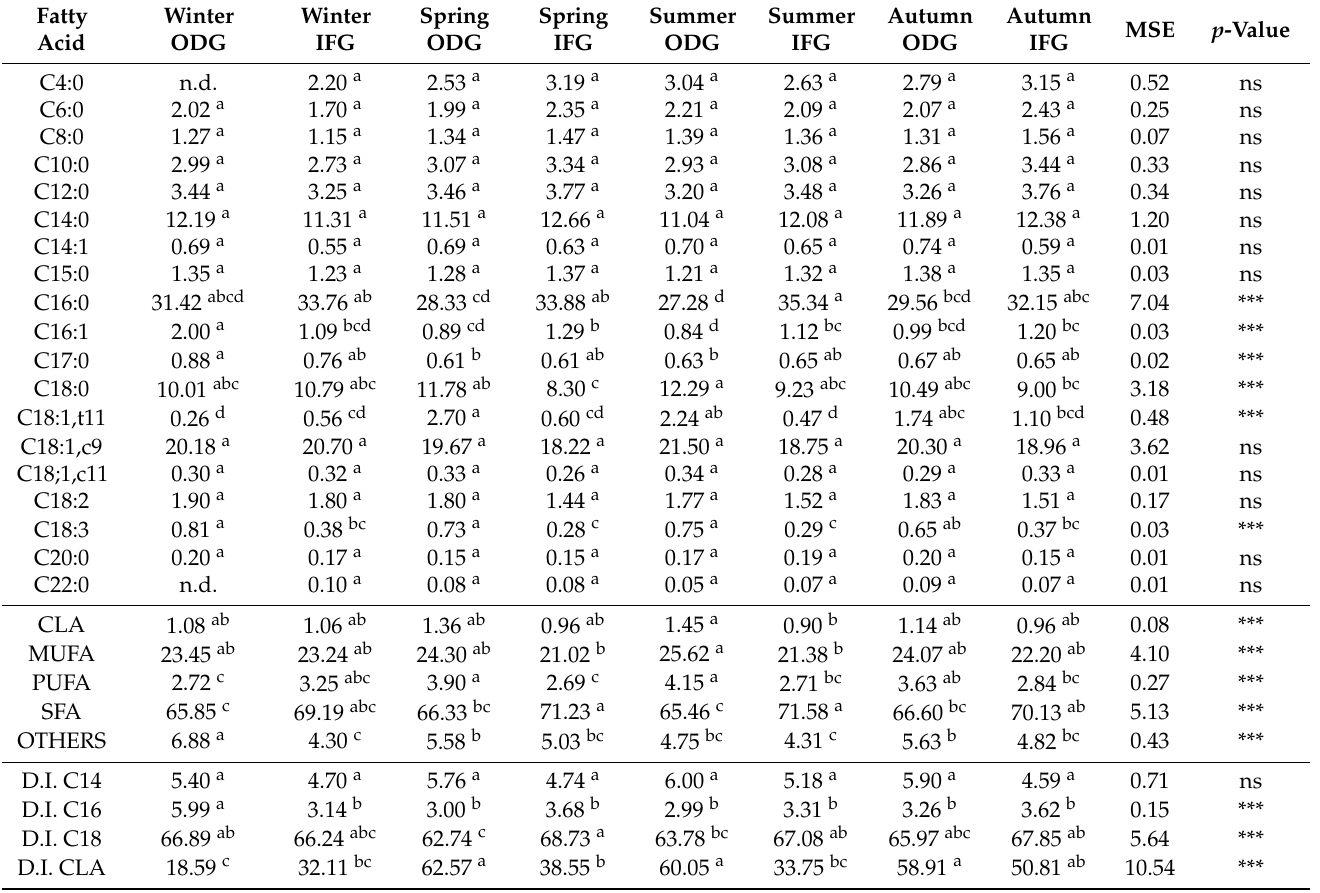
Table 2. Fatty acid profile in bovine milk samples collected in four seasons from two different farming systems.